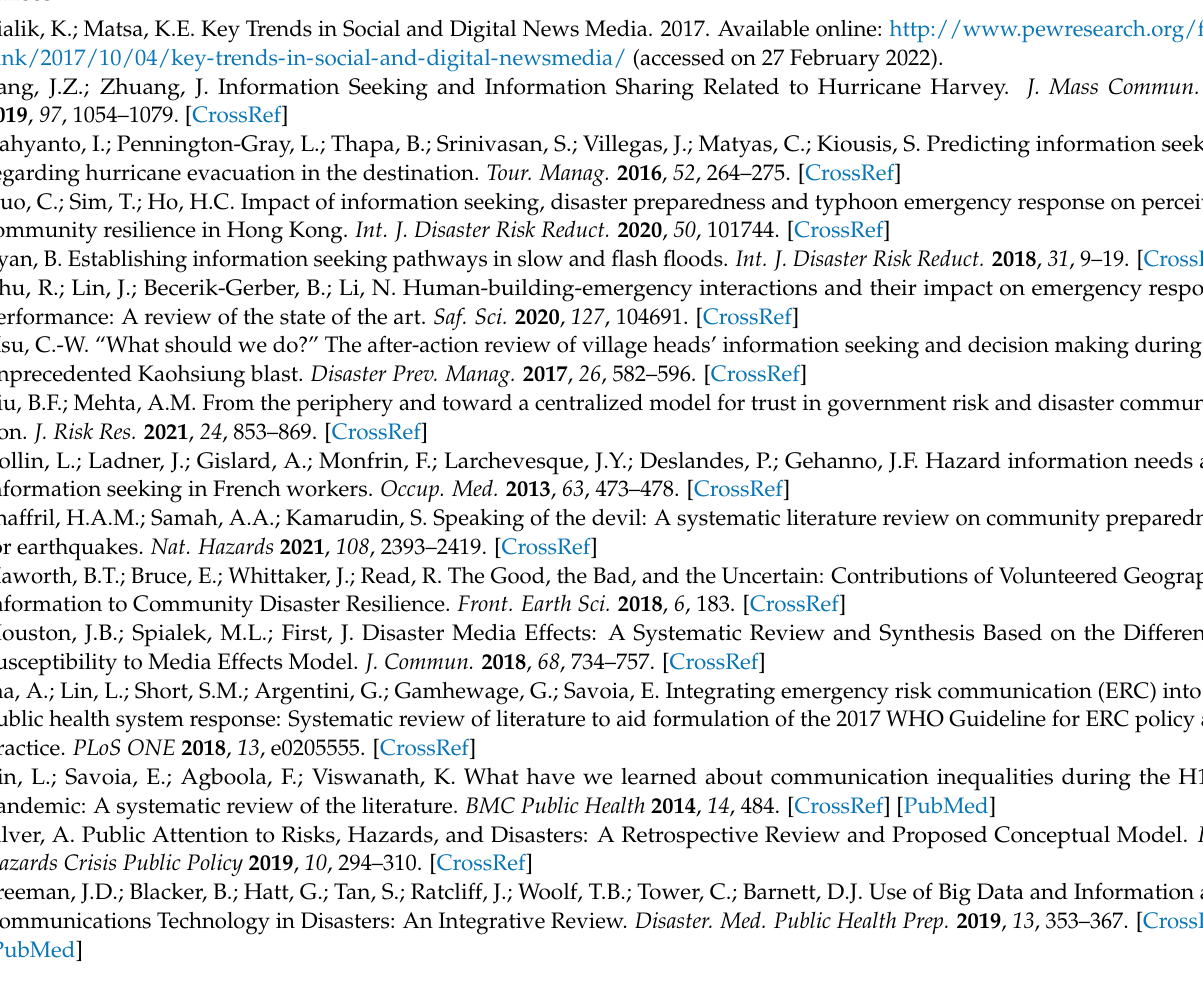
Figure A2. Collaboration network map of main institutions.